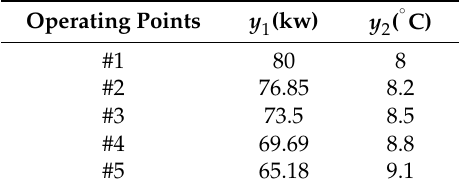
Table 1. Typical operating points of MGT-CCP